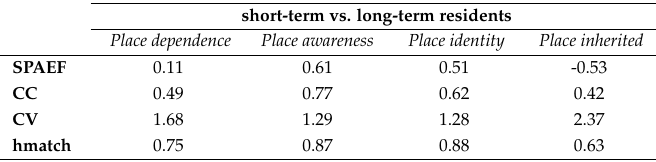
Table 4: Spatial Efficiency metric (SPAEF); Pearson correlation (CC); Ratio of coefficient of variation (CV); and histogram overlap (hmatch) between participant groups for each dimension of sense of place.